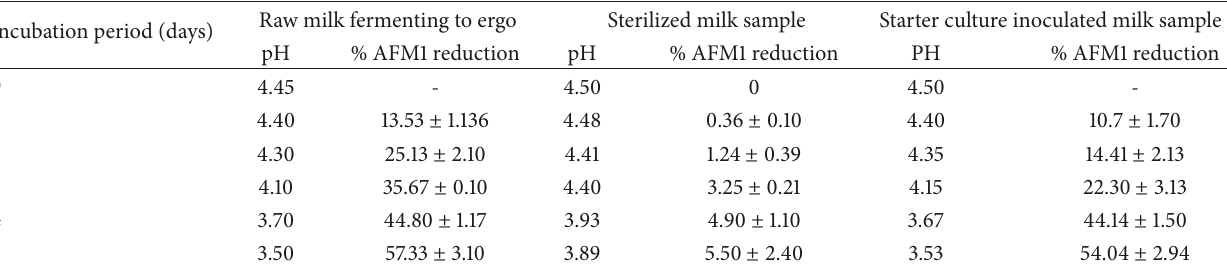
Table 2: Effect of pH on the fate of AFM1 in naturally fermenting milk (ergo) at 25 ∘ C.